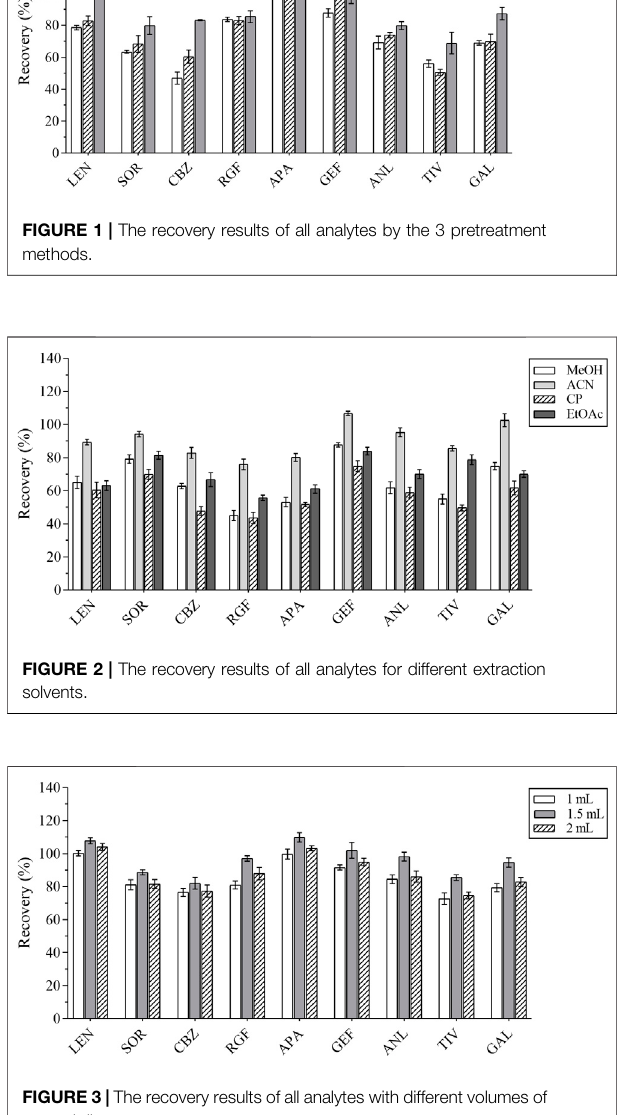
Frontiers in Pharmacology |